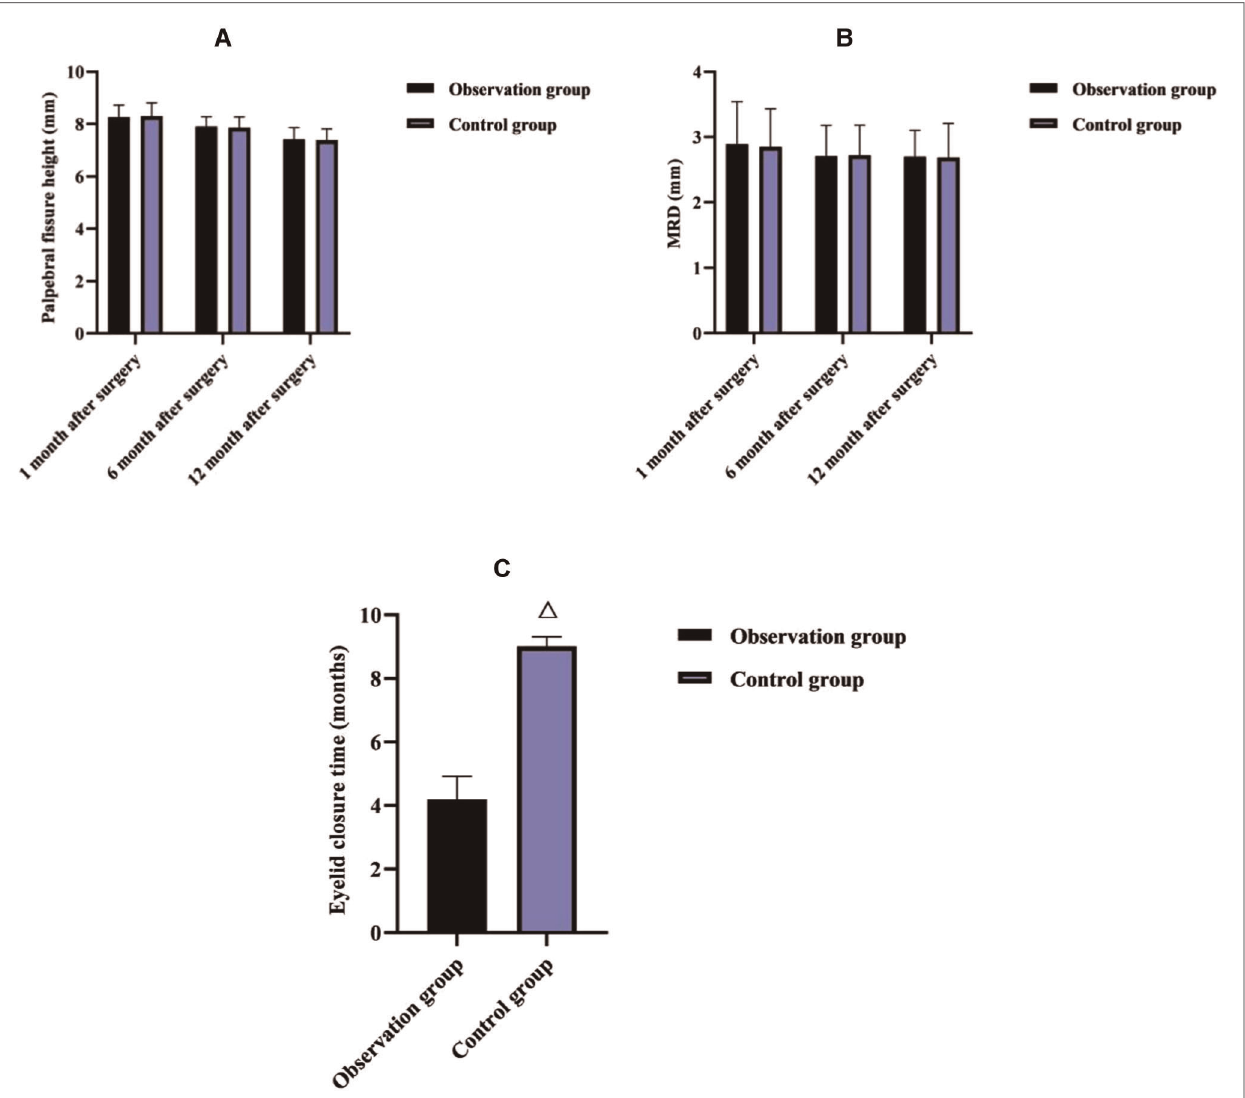
Figure 1 | Comparison of eyelid status between two groups in each month after surgery ( (cid:1) x + s ). Note: ( A ) Palpebral fi ssure height (mm). ( B ) MRD (mm). ( C ) Eyelid closure time (months). Note: Compared with the observation group, △ p